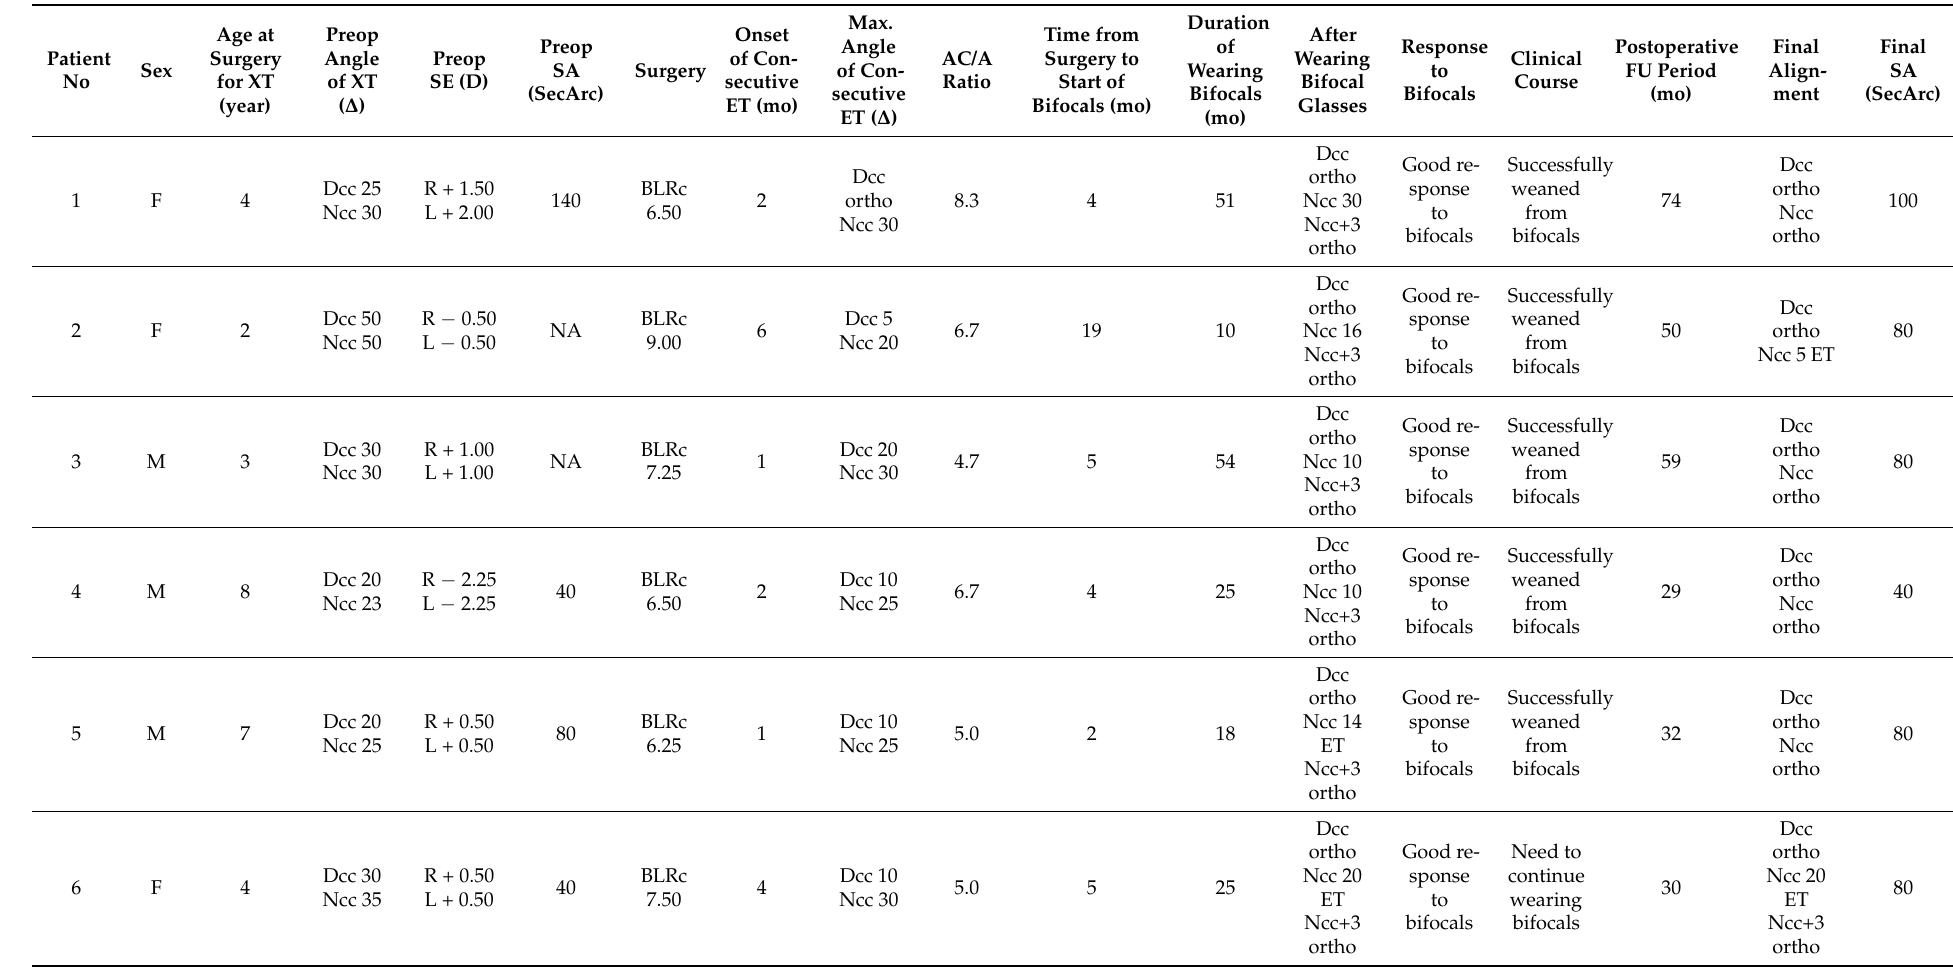
Table 2. Preoperative clinical features and final outcomes of patients with high AC/A ratio consecutive